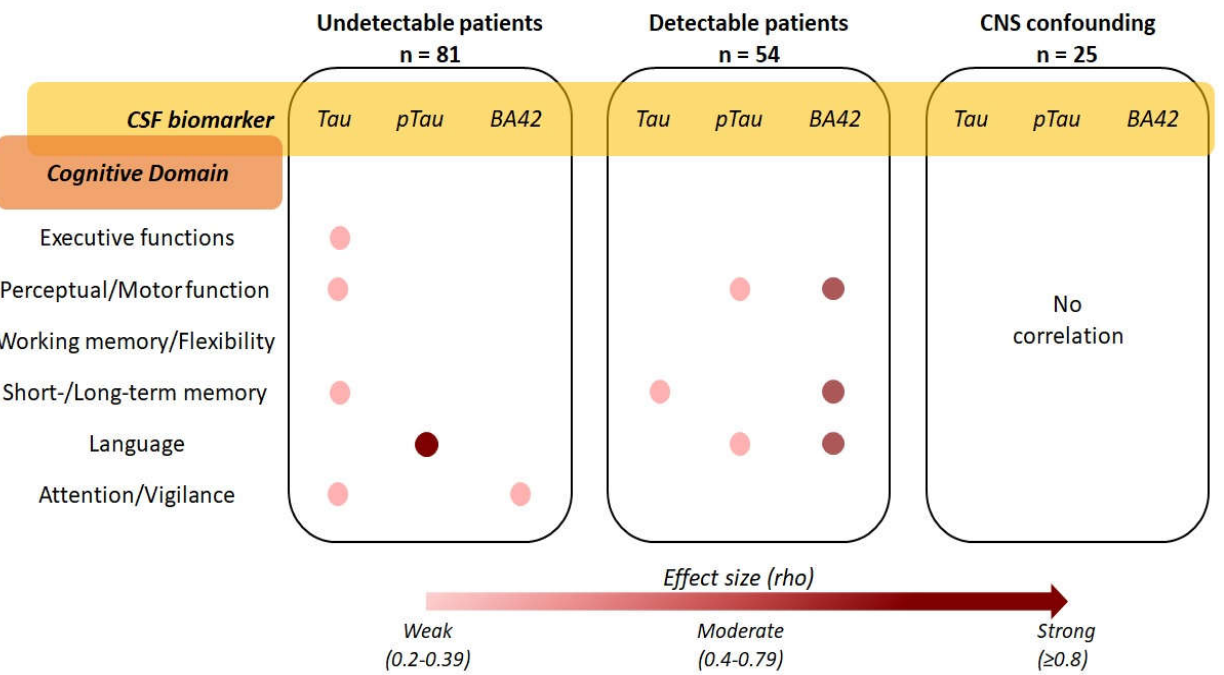
Figure 4. Strength and interpretation of the correlations between cerebrospinal fluid tau, ptau, and β Amyloid 1–42, and the results of the neurocognitive assessment in the three HIV-positive clinical groups (the exact rho values of the significant Spearman’s correlations are reported in the respective results sections).